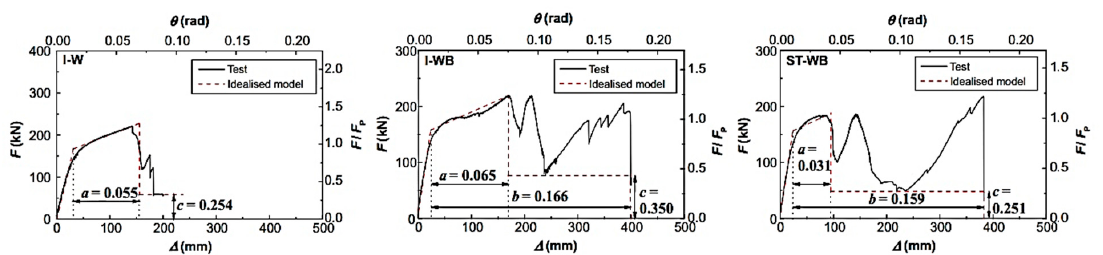
Figure 12. Ductility assessment of fully rigid tested specimens.